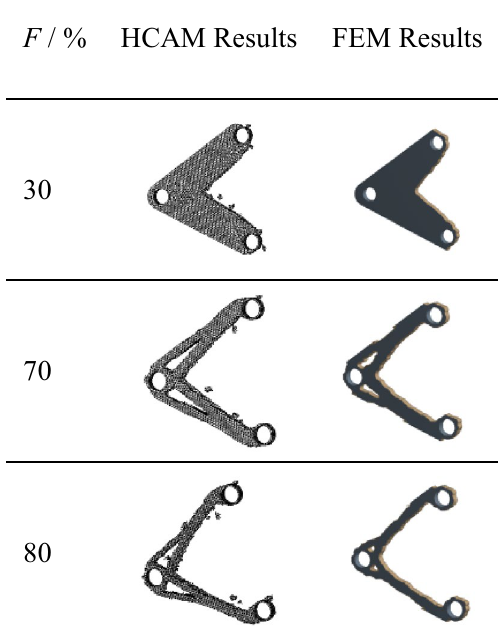
Table 2. Comparison of optimization results of different mass ratios of triangular coupling plates.